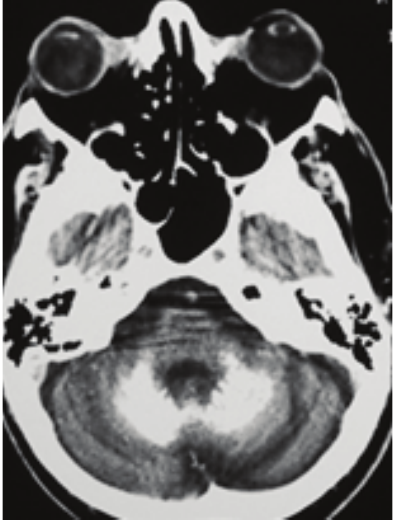
Figure 3: CT scan axial view demonstrating calcifications in both cerebellar